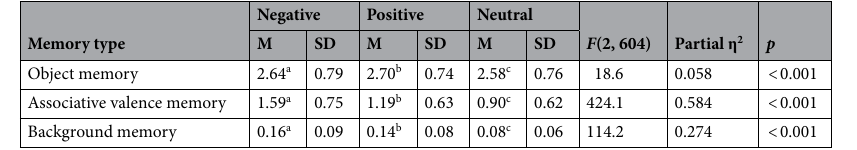
Table 1. The mean and standard deviation of memory scores for participants across all ages (18–87 years old). The object memory refers to participants’ memory performance for neutral objects learned with positive, negative or neutral backgrounds. The associative valence refers to memory for whether each neutral object was associated with a positive, negative or neutral background. The background memory concerns memory performance for the details of the background image associated with each neutral object 46 . The d ′ scores are used for the object and associative valence memory. The proportion of correct gist memories is used for the background memory measure. Means with different subscript letters were statistically different ( p < 0.05) according to pairwise comparisons with Bonferroni